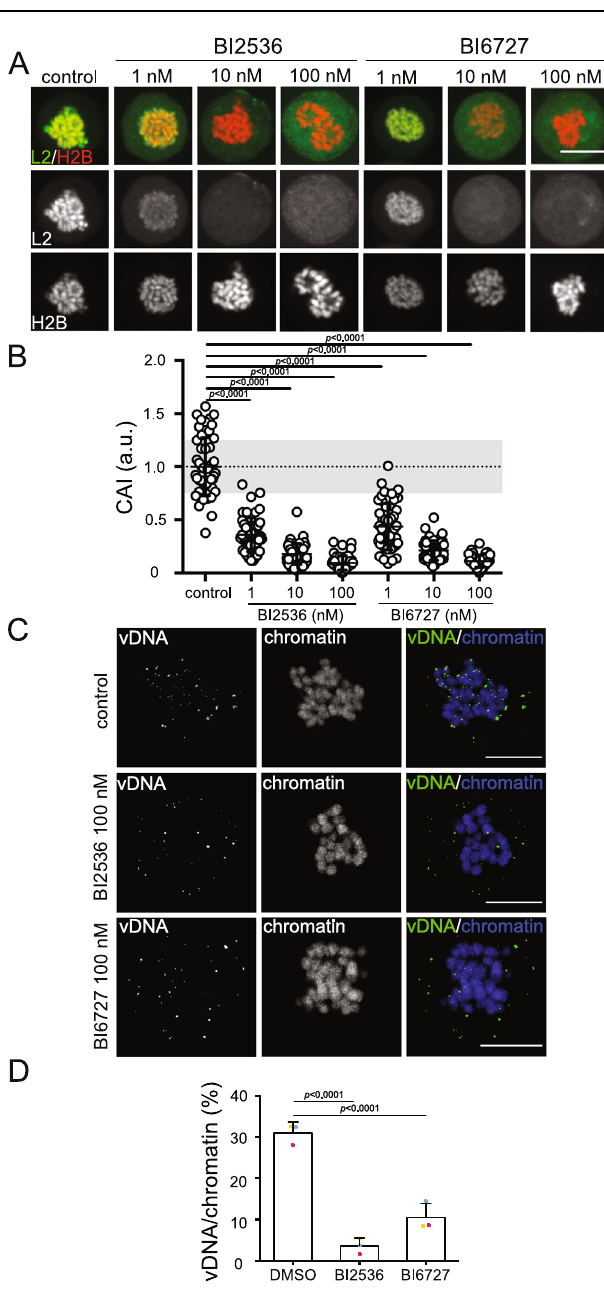
Fig. 4 | PLK1 inhibition impairs HPV16-L2 chromosomal association and vDNA deliverytohostmitoticchromatin.A HeLacellsstablyexpressingL2-EGFP/H2B- mCherry were incubated in presence of the indicated PLK1 inhibitors (100nM) for 16h, arrested in mitosis using nocodazole (330nM), and processed for chromo- somal association assay as in Fig. 1B. Depicted are representative single medial planes of spinning disk confocal microscopy with L2-EGFP in green and H2B- mCherry in red as indicated. Scale Bar: 10 µ m. B Quanti fi cation of A , displaying the chromosomalassociationindex(CAI)ofindividualcells(circles),i.e.theintensityof H2B-mCherry-overlapping EGFP signal over total intensity 4 . Values were normal- izedtoEGFPalone(0)andL2-GFP(1).50cellsfromthreeindependentexperiments were analyzed. Displayed is the average of three independent experiments±SD. C HeLa cells were infected with WT L2 HPV16-EdU PsV for 20h, then released into mitosis in presence of nocodazole (330nM – control), nocodazole and BI2536 (100nM),ornocodazoleandBI6727(100nM).Displayedarerepresentativemedial confocal slices of the subcellular localization of vDNA (EdU, green) and nuclei (Hoechst - blue) in mitotic cells. Scale bars: 5 µ m. D Quanti fi cation of C for three independent experiments with eight cells/experiment. The overlap of vDNA/ chromatin was quanti fi ed using intensity-based colocalization analysis (IMARIS Coloc function). Displayed is the average of three independent experiments±SD. Colored dots represent data points of individual experiments. Statistical sig- ni fi cance was assessed by two-tailed Student ’ s t test to control. Source data are provided as a Source Data fi